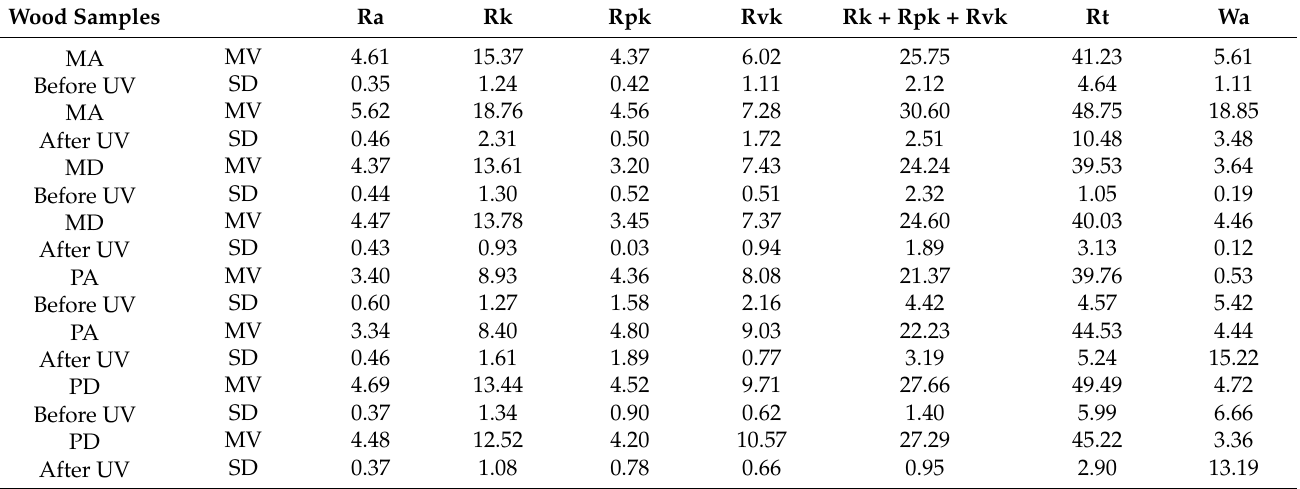
Figure 6. Color comparison between wood samples before and after artificial aging: ( a ) spruce samples, grade A; ( b ) spruce samples, grade D; ( c ) sycamore maple samples, grade A; ( d ) sycamore maple samples, grade D. Table 2. The average values (MV) of the roughness parameters (in microns) and their standard deviations (SD), as measured before and after exposure to